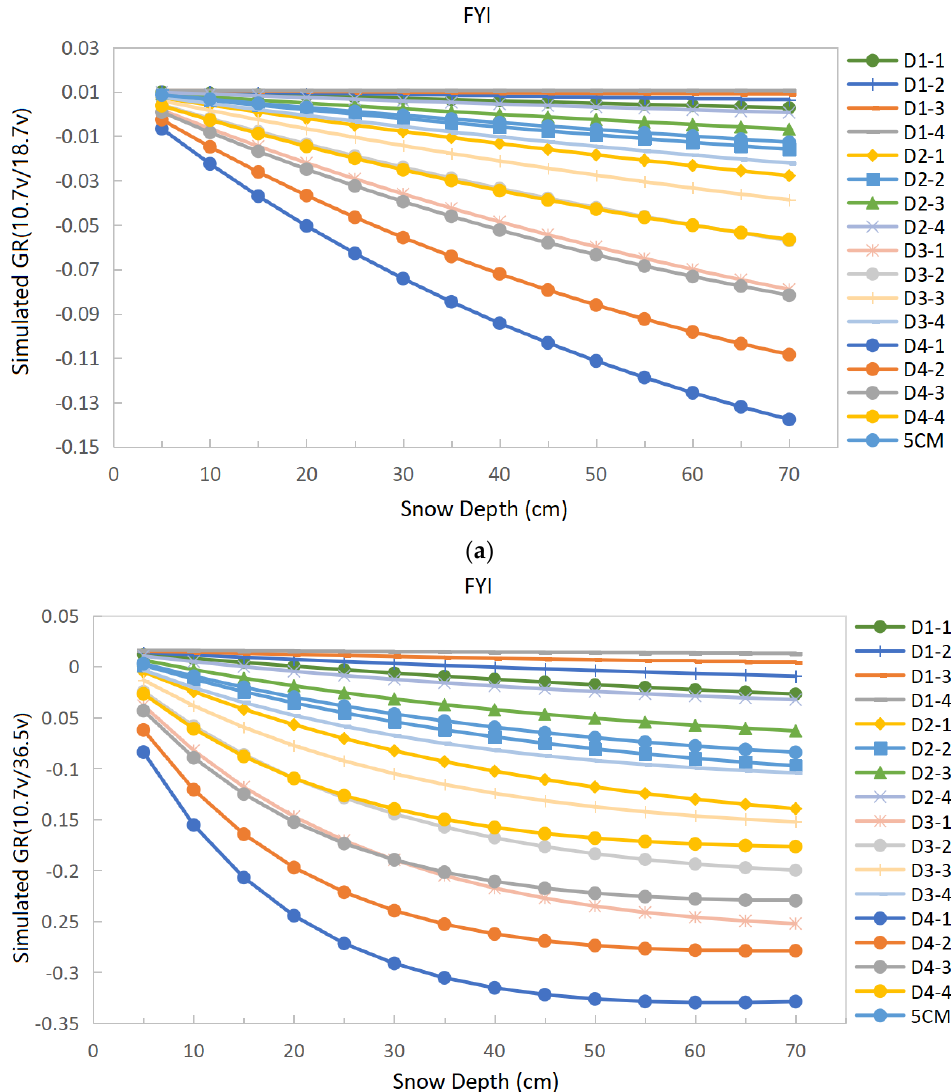
Figure 5. Variation in GRs with snow depth on FYI under different conditions. ( a ) GR(10.7 V/18.7 V); ( b ) GR(10.7 V/36.5 V).